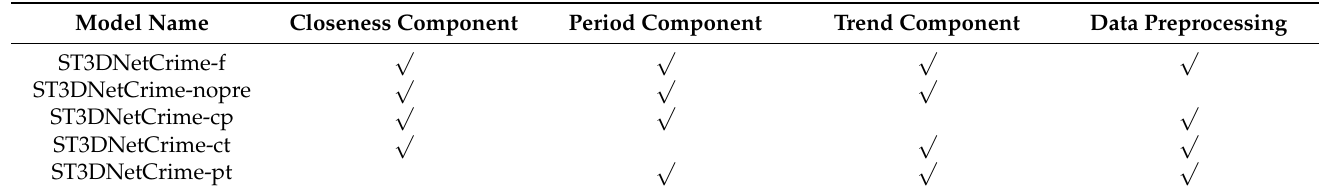
Table 2. Combination settings of temporal properties and corresponding model name